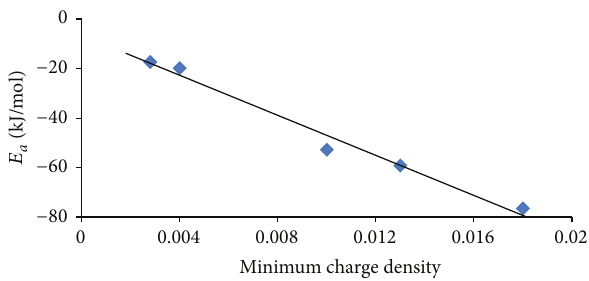
Figure 4: Relationship between the adsorption energy and the minimum charge density around the rare gas